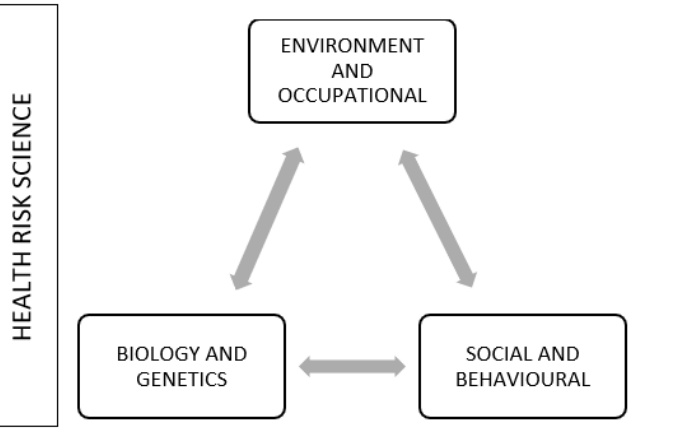
Figure 1. Three basic sets of health risk science. The arrows, in gray, indicate the mutual interaction among determinants.